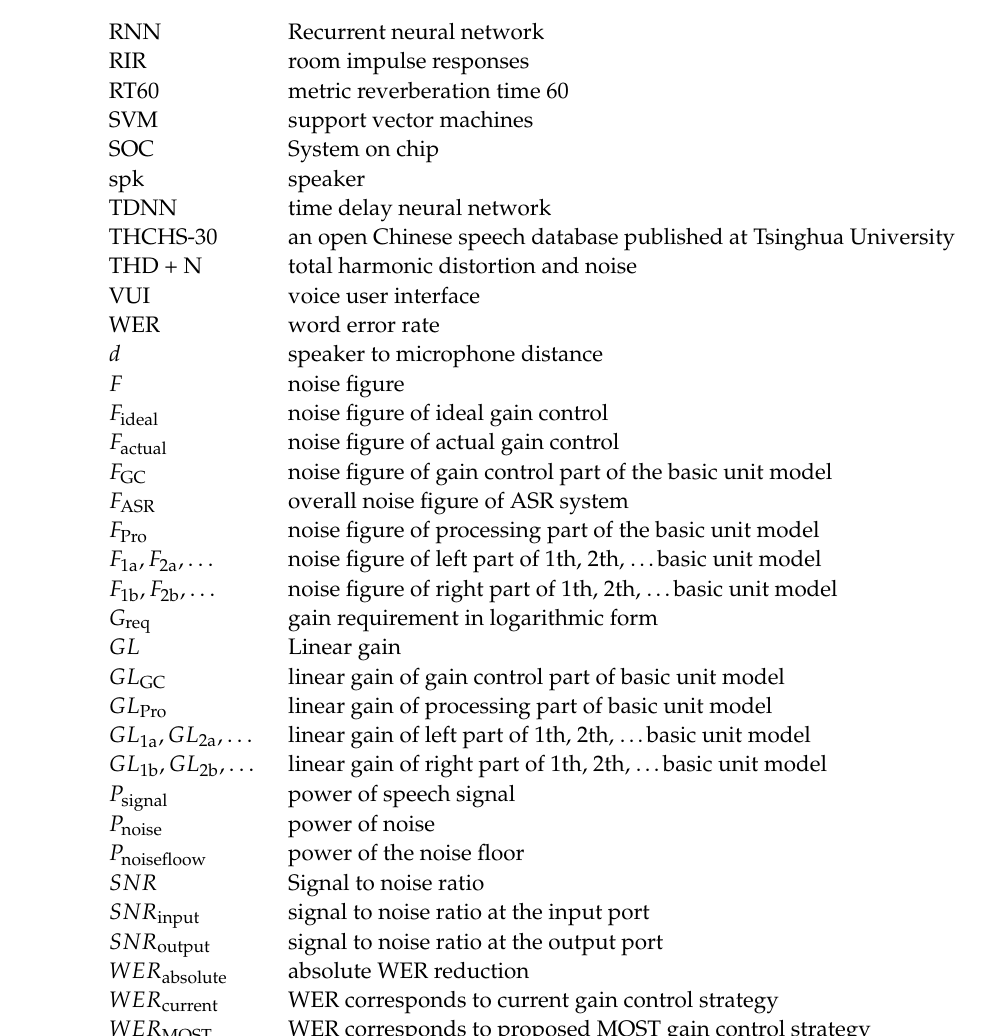
noise figure of actual gain control noise figure of gain control part of the basic unit model overall noise figure of ASR system noise figure of processing part of the basic unit model noise figure of left part of 1th, 2th, ...basic unit model noise figure of right part of 1th, 2th, ...basic unit